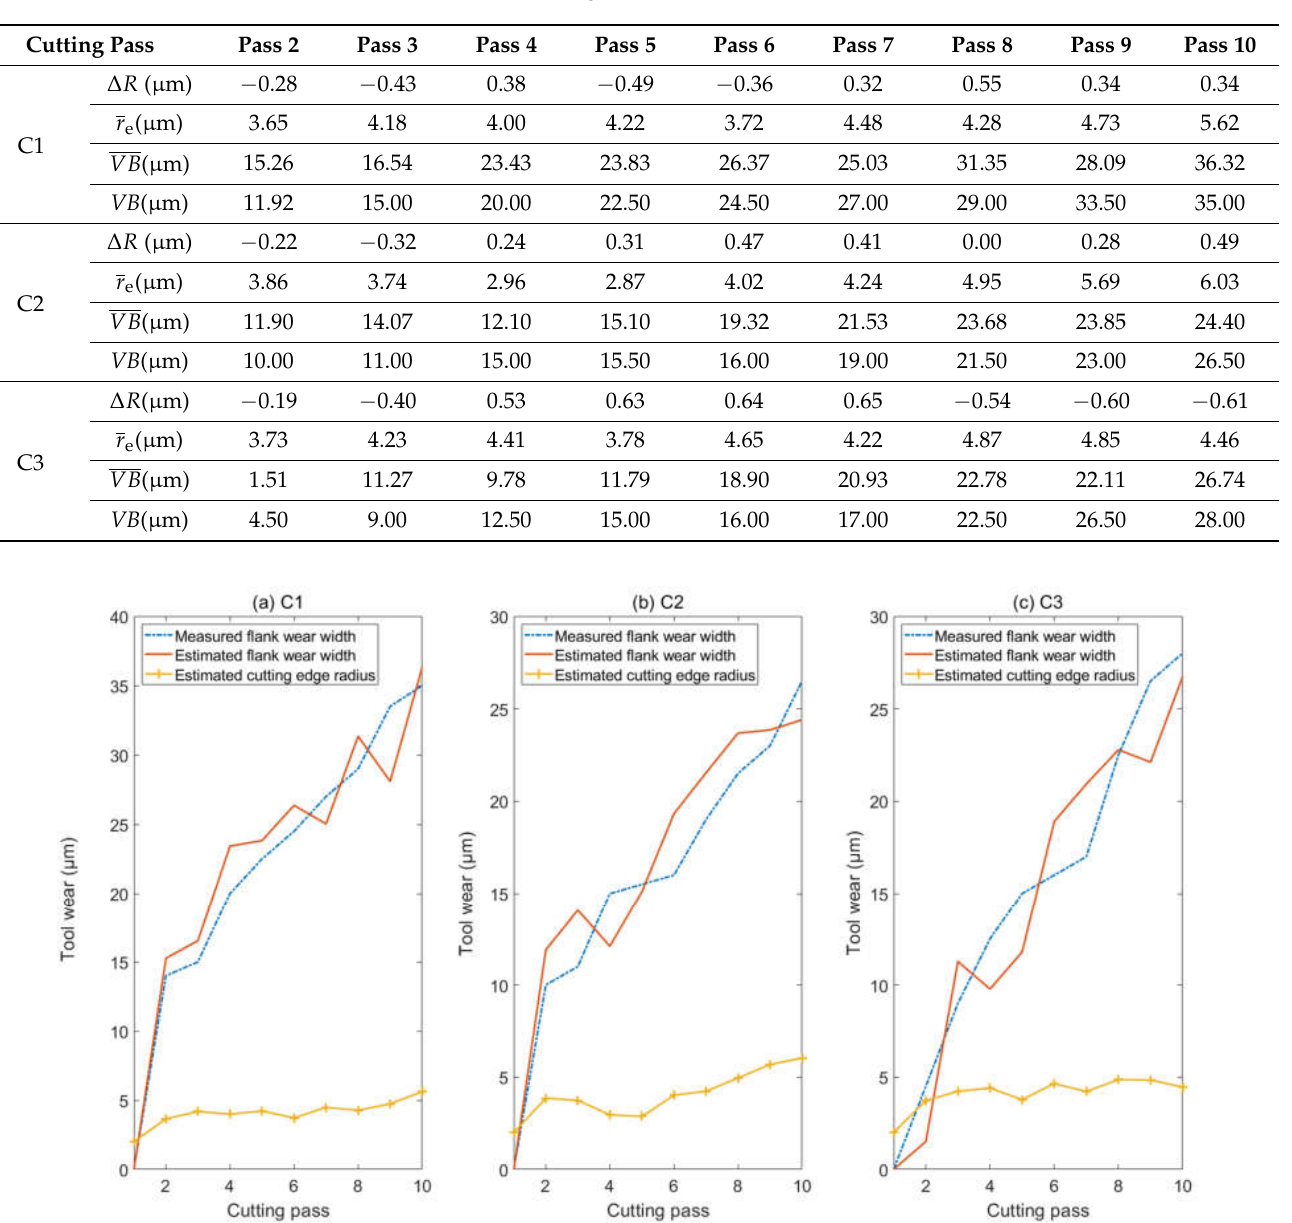
Figure 6. The estimated flank wear width and the cutting-edge radius. ( a )Tool wear in C1; ( b ) Tool wear in C2; ( c ) Tool wear in C3.